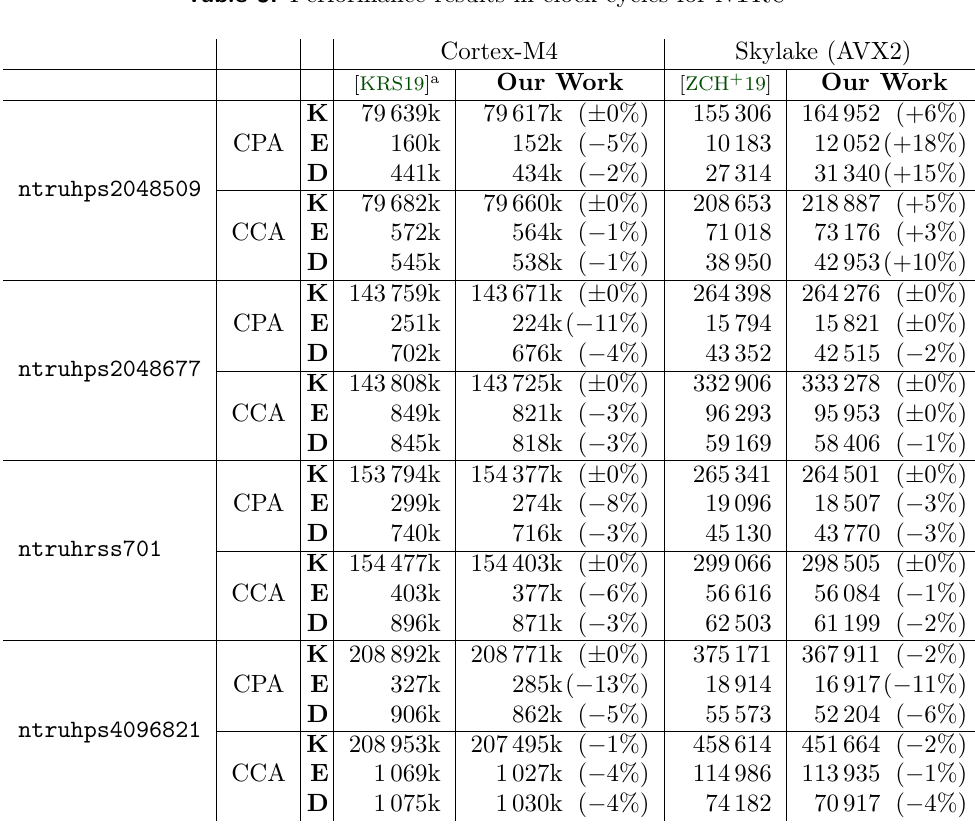
Table 8: Performance results in clock cycles for NTRU Cortex-M4 Skylake (AVX2) [KRS19] a Our Work [ZCH + 19] Our Work